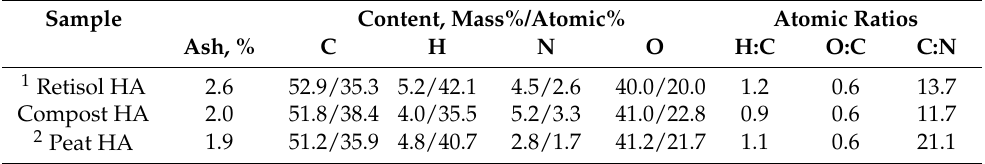
Table 2. Elemental composition of the humic